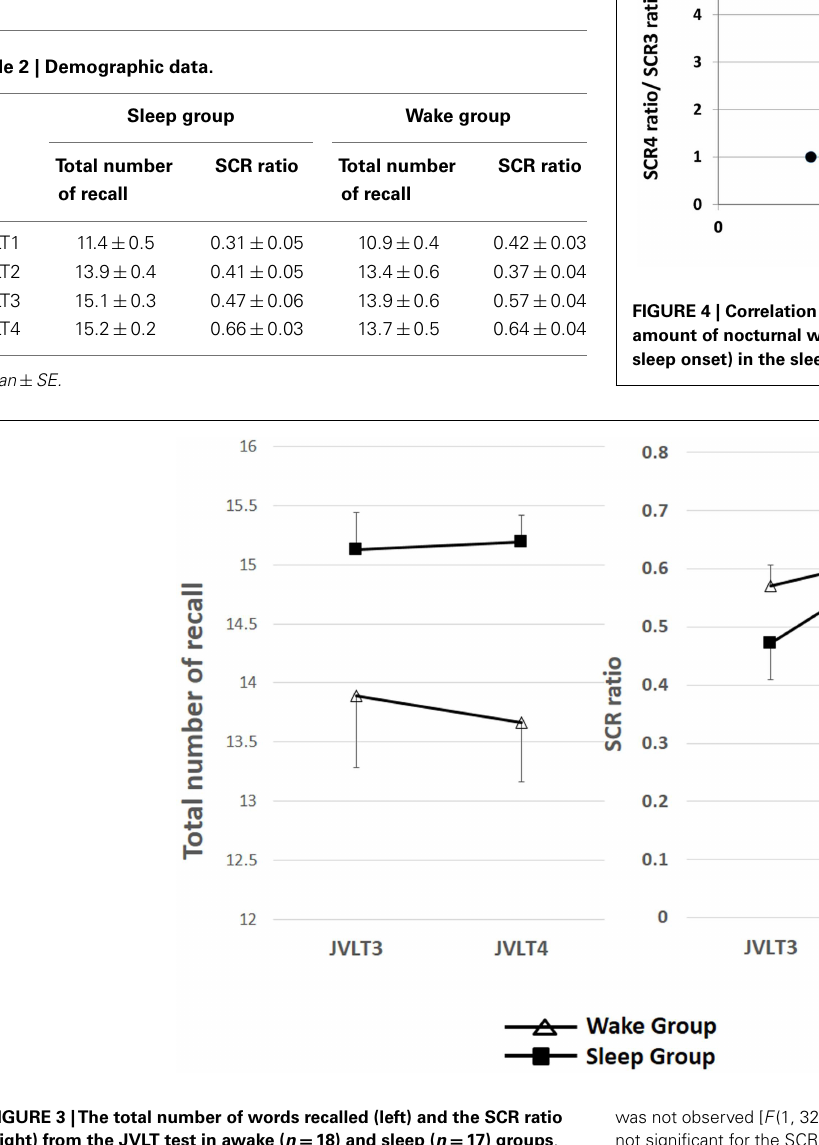
FIGURE 3 |The total number of words recalled (left) and the SCR ratio (right) from the JVLT test in awake ( n = 18) and sleep ( n = 17) groups . Time × Group interaction effect was not significant for the total number of words recalled [ F (1, 32) = 0.26, p = 0.61], and a significant main effect of time